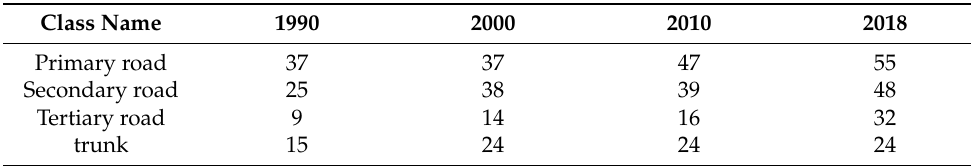
Table 6. Roads statistics per kilometer from 1990 to 2018.